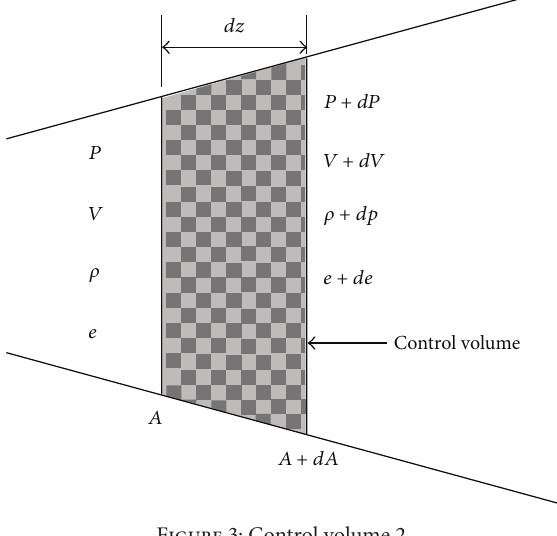
Figure 3: Control volume